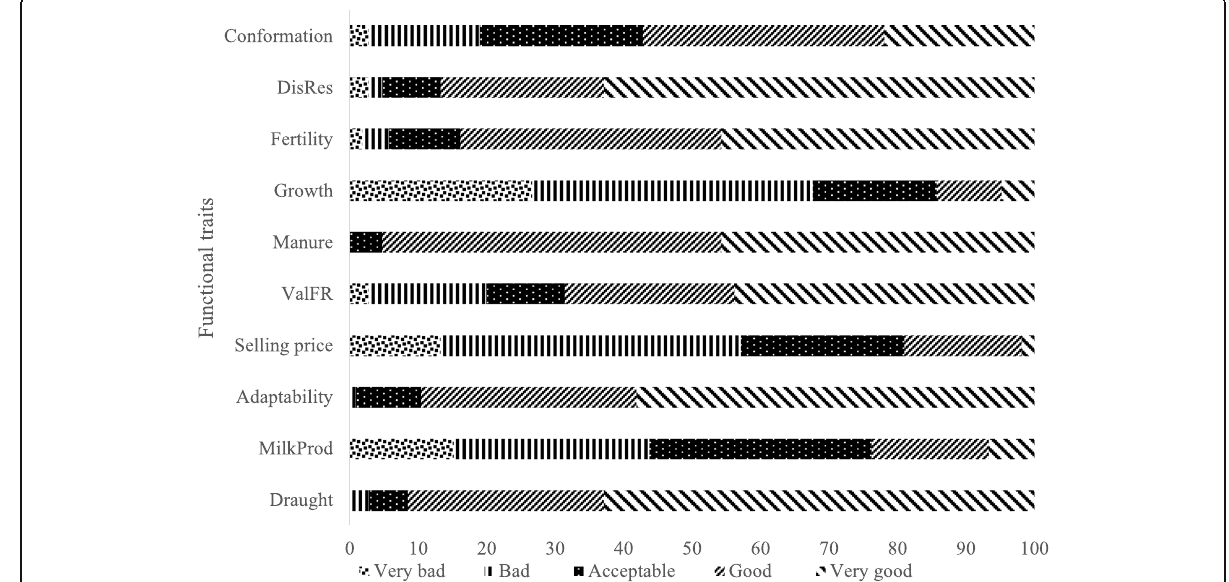
Fig. 4 Perceived functional traits in the Borgou cattle breed. DisRes disease resistance, MilkProd milk production, ValFR valorization of feed